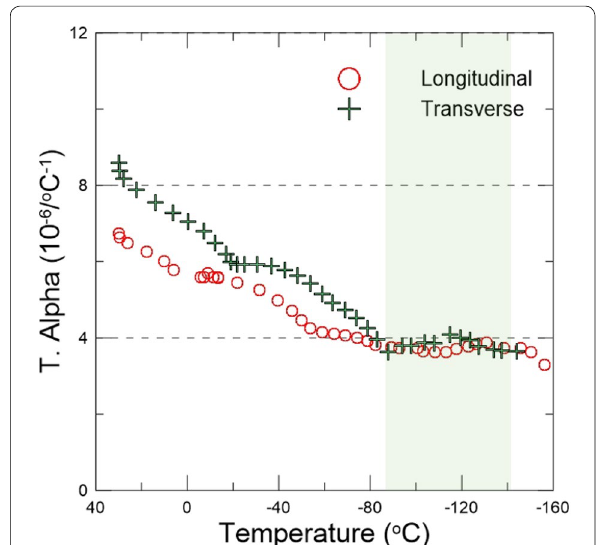
Fig. 19 Thermal expansion coefficient of